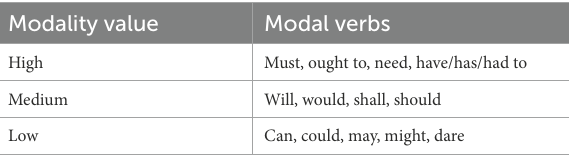
TABLE 1 Halliday’s classification of modality values in English.